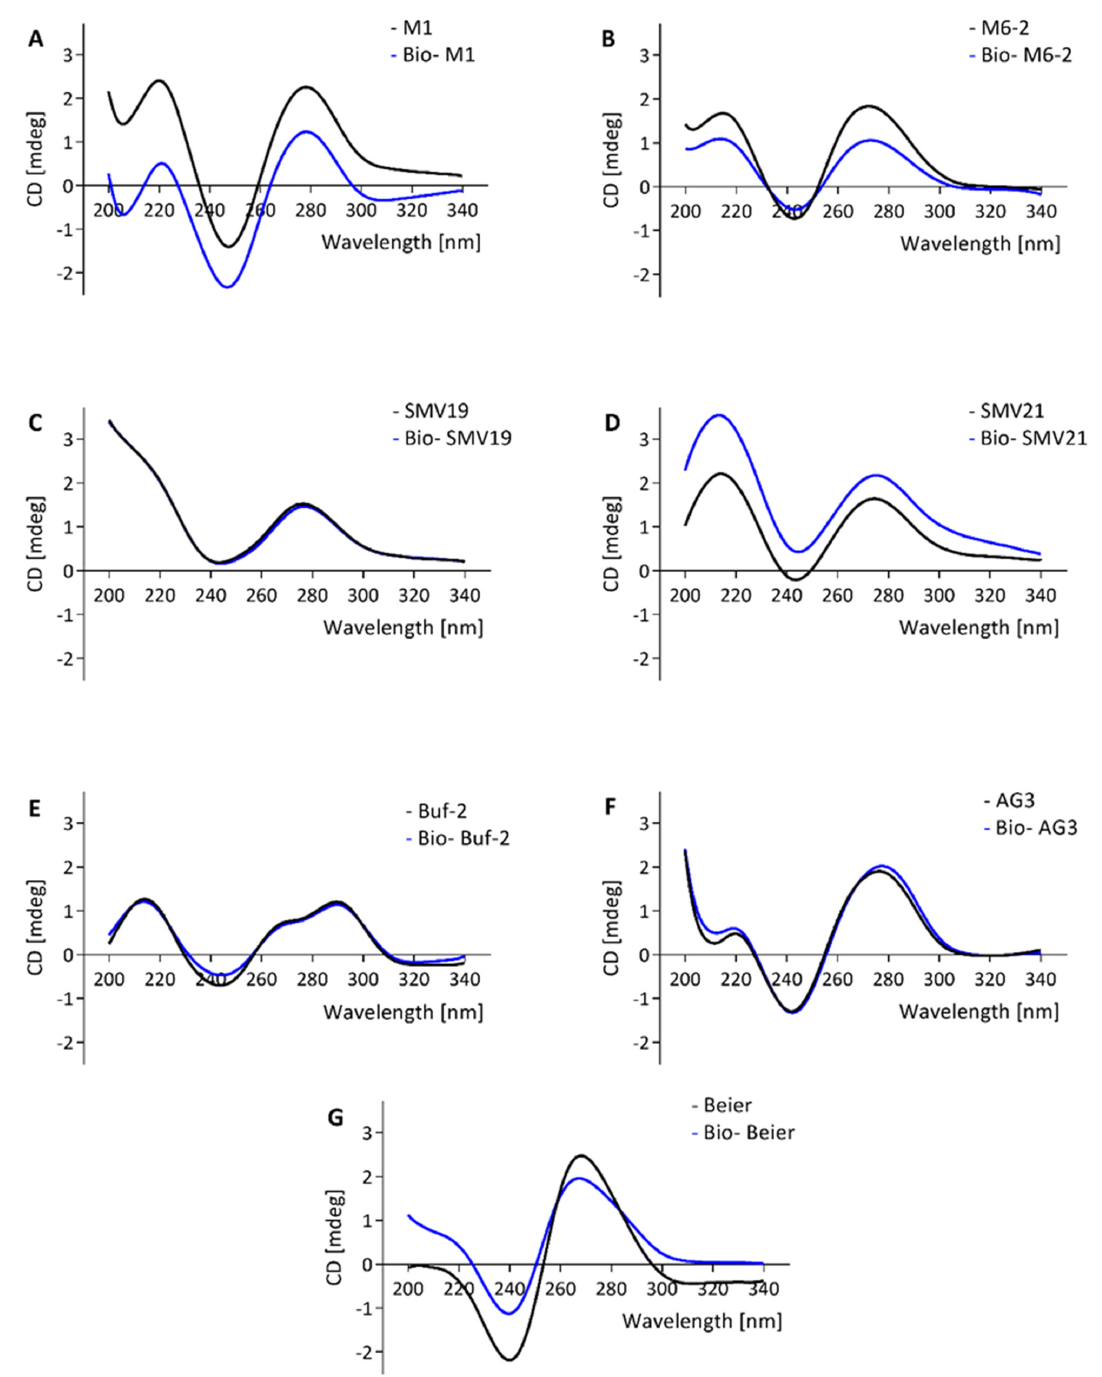
Figure 2. CD spectra of aptamer candidates M1, M6-2, SMV19, SMV21, Buf-2, AG3, and Beier (black curve) and the same biotinylated candidates (blue curve) are shown in ( A – G ), respectively.